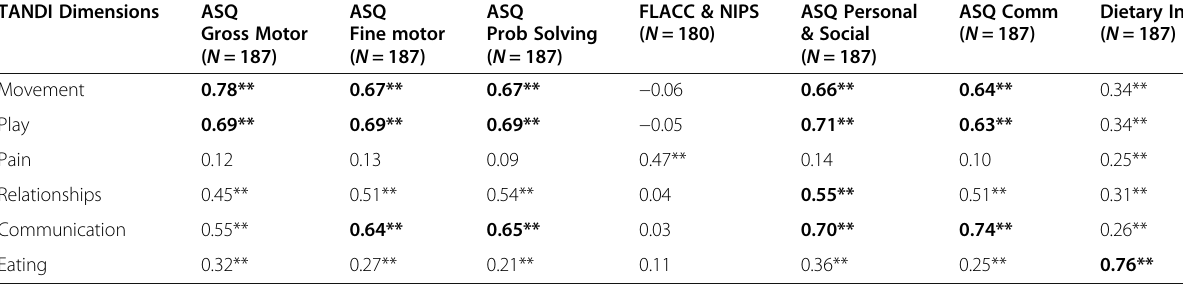
Table 5 Spearman ’ s Rho Correlations of TANDI Dimensions TANDI Dimensions